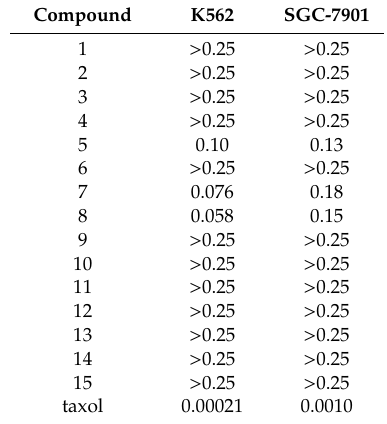
Table 4. Cytotoxic activities of compounds 1–15 against K562 and SGC-7901 cell lines (IC 50 ,